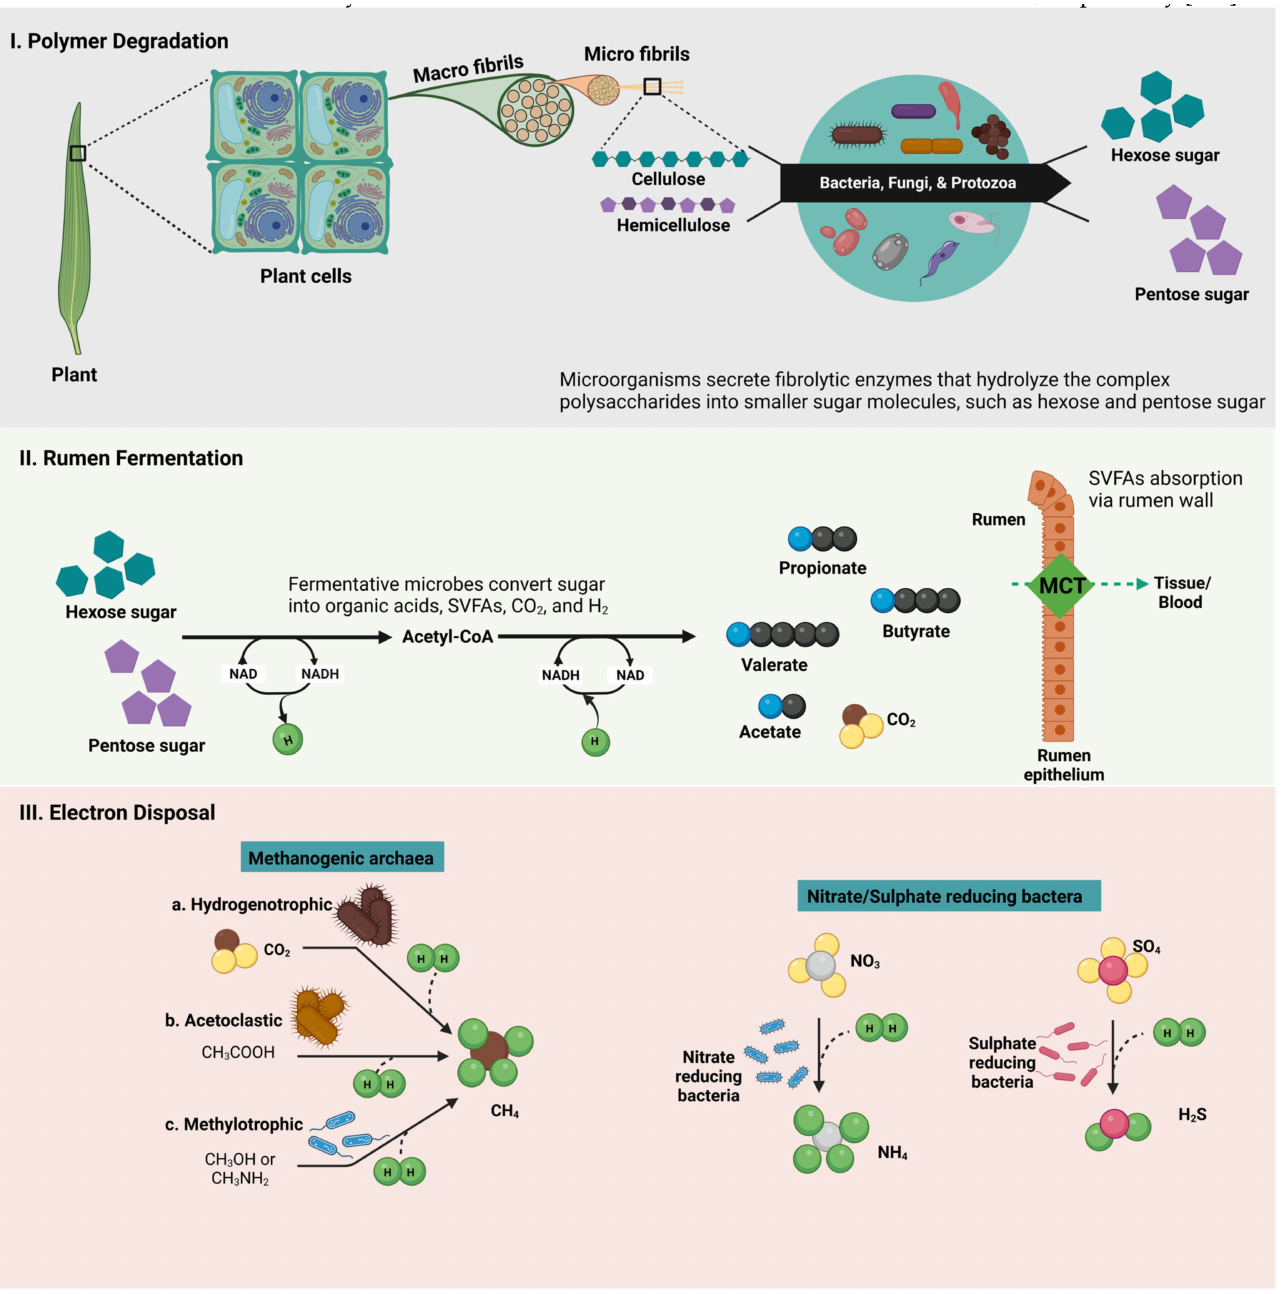
Figure 3. Rumen metabolic cascades represented by three stages of metabolic events: polymer degradation ( I ), rumen fermentation ( II ), and electron disposal ( III ). Blue hexagon and purple pentagon represent hexose and pentose sugar, respectively. Dark grey circle and blue circle represent methyl and carboxyl group, respectively. Circles with different color represent different elements: brown (carbon), yellow (oxygen), green (hydrogen), light grey (nitrogen), and pink (sulfur). SVFA: Short volatile fatty acids. MCT: monocarboxylate